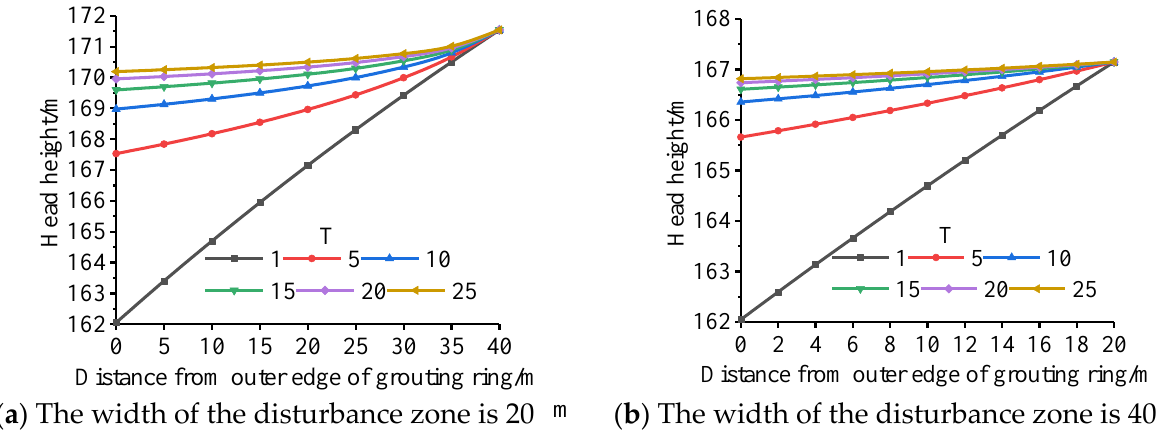
Figure 4. Water head curve at the location of the disturbance zone.